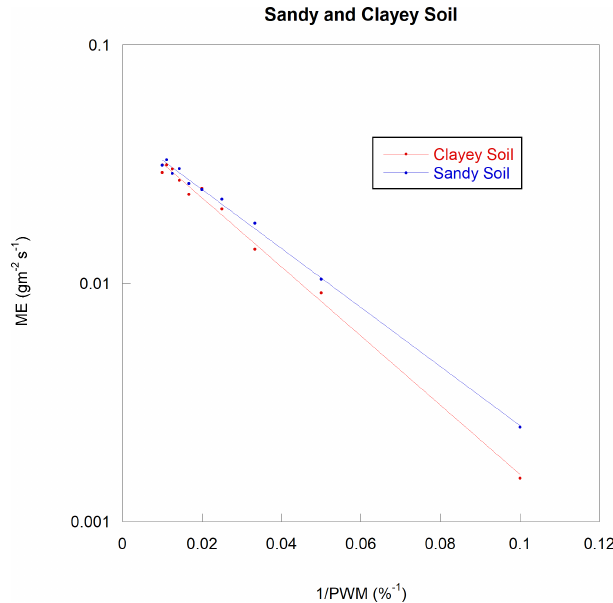
Figure 5. Measured evaporation rate versus 1 / PWM for sandy soil under 0.72ms − 1 wind and for clayey soil under 0.8ms − 1 wind